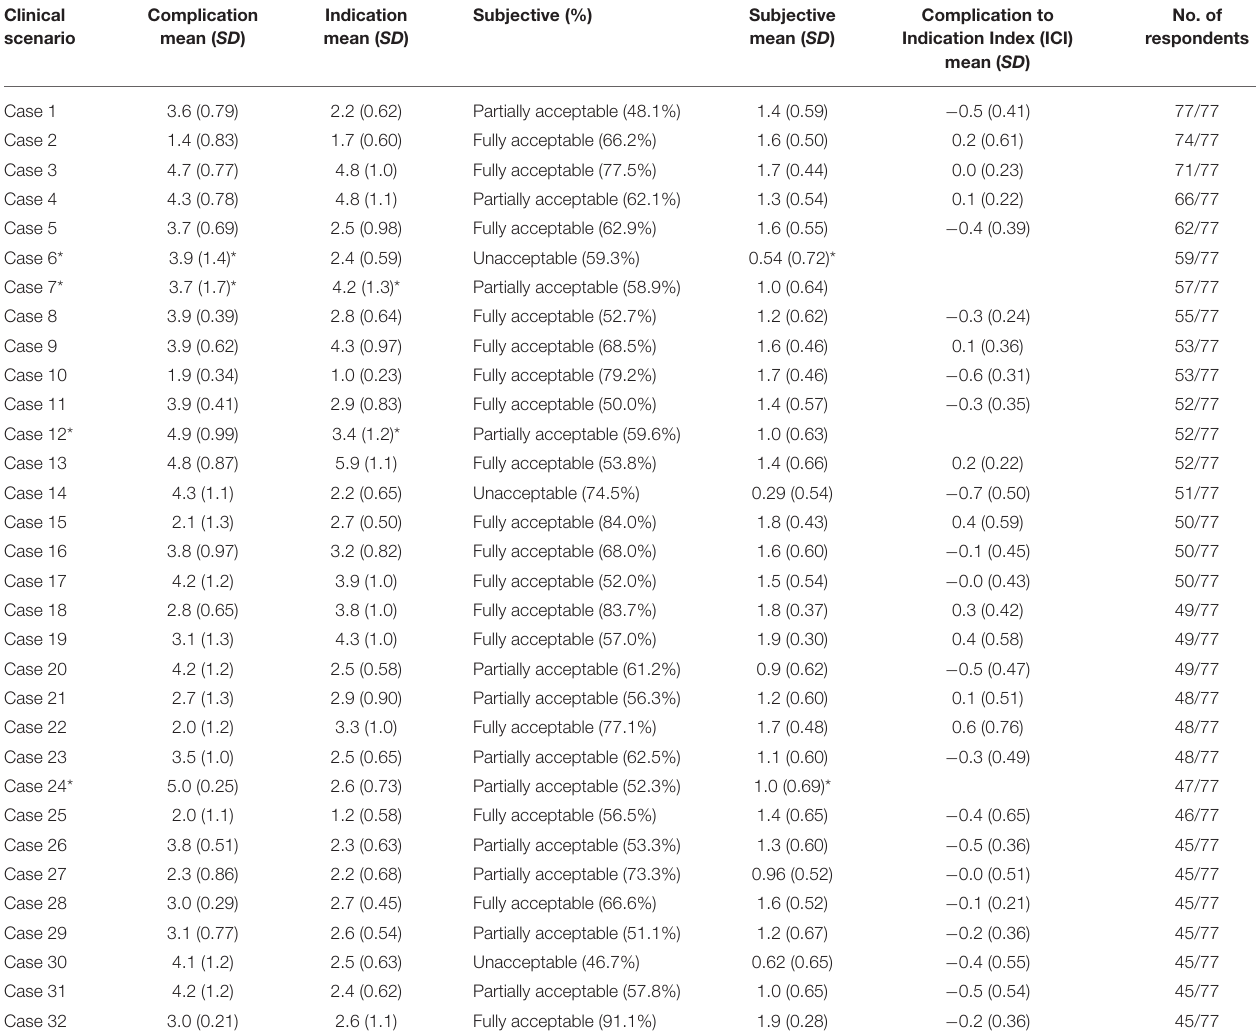
TABLE 3 | Descriptive statistics with distribution of grading for each clinical scenario.